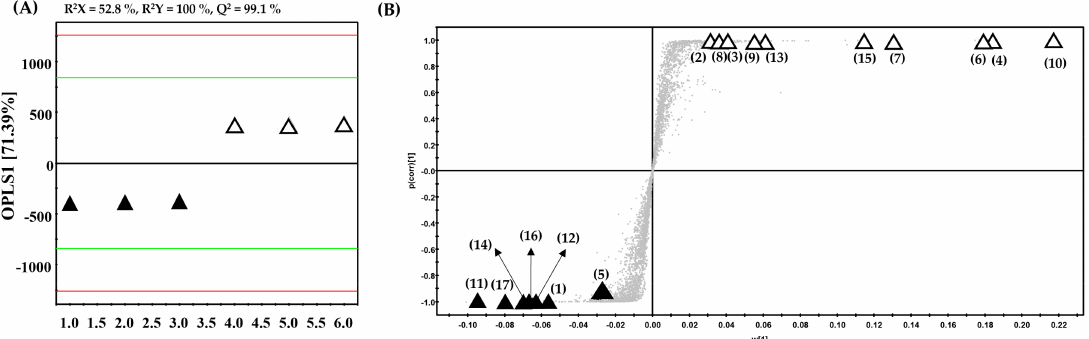
Figure 2. Multivariate statistical analysis of LC-MS datasets for 40% methanol SPE extracts of A. aspera (unfilled triangles) and Z. serrata (filled triangles): ( A ) OPLS-DA score plot, with VIP >1.0 and p -value <0.05 marked; ( B ) loading S-plot based on OPLS-DA. Numbers labeling each sample (cid:48) s discriminant metabolites on the plot correspond to entries in Table